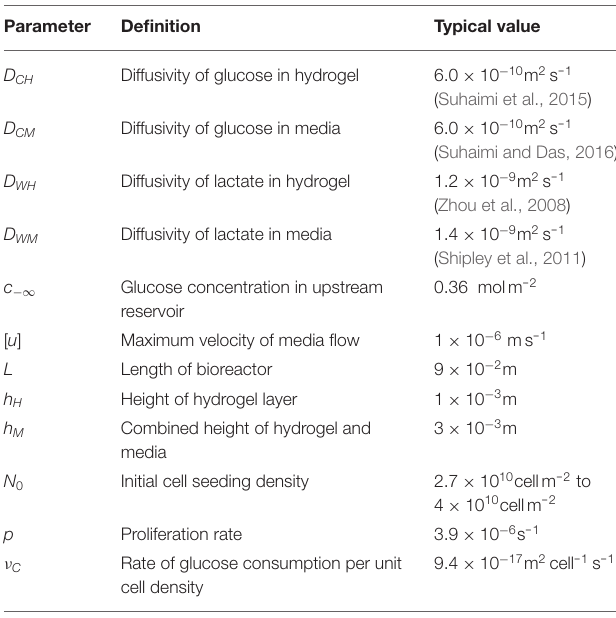
TABLE 1 | Definitions of dimensional model parameters, together with typical